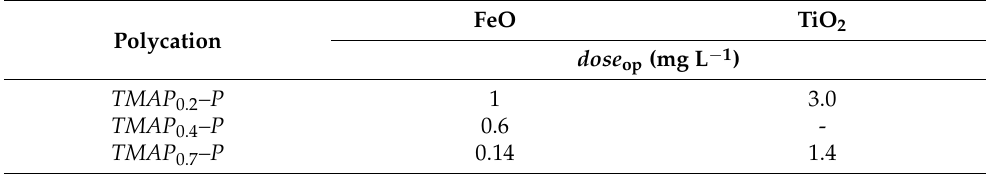
Table 2. Ionic group content influence on dose op.